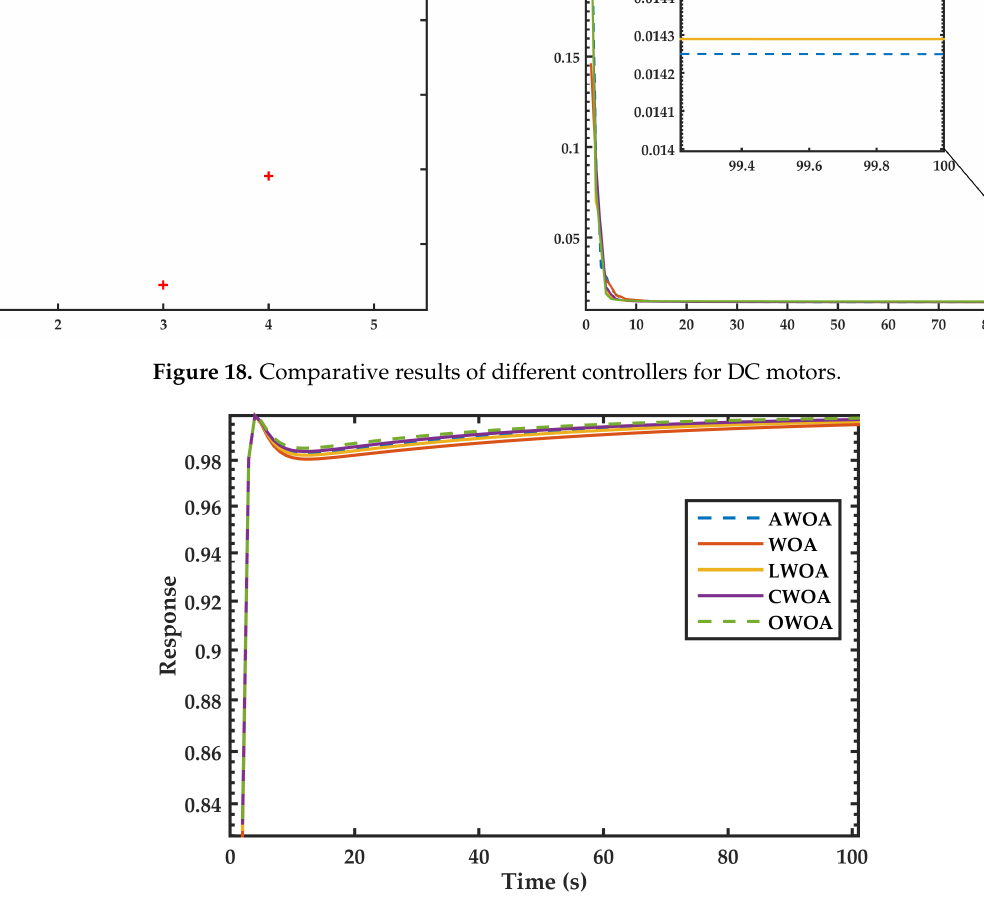
Figure 19. Step Response Analysis of Different